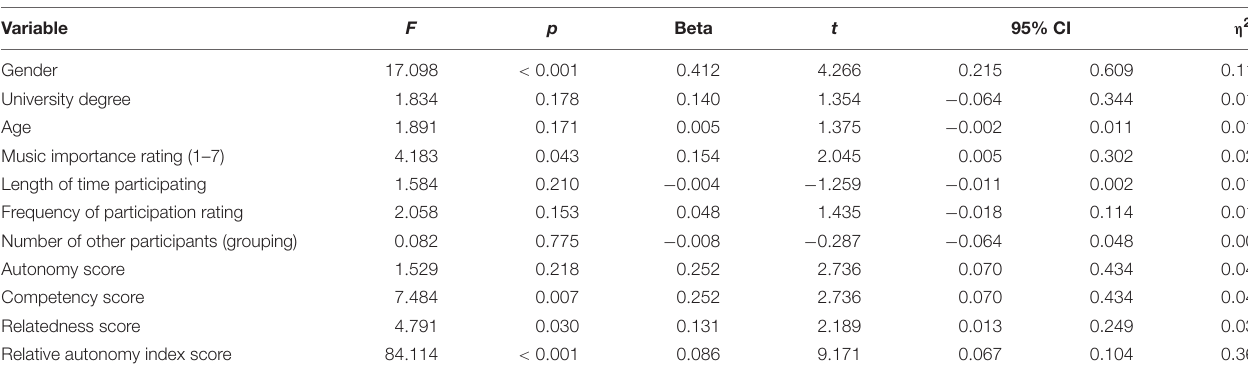
TABLE 2 | Total well-being score model.